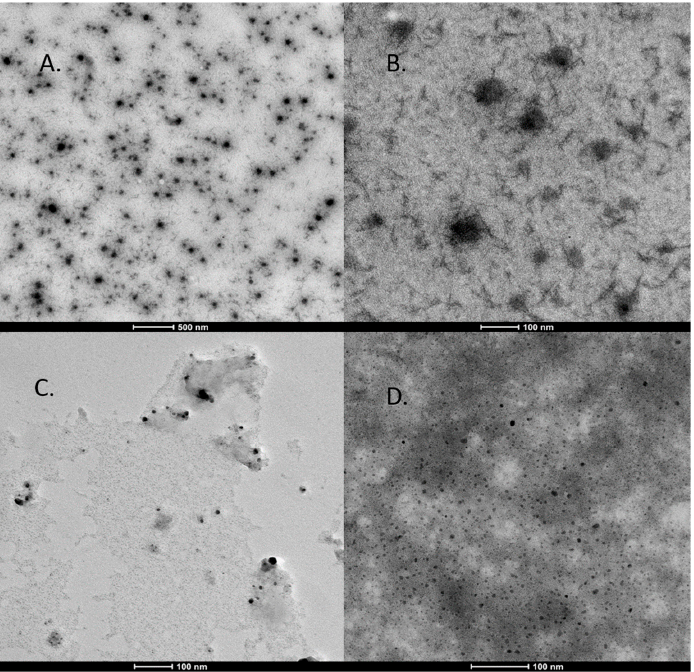
Figure 6. TEM analysis of bimetallic NPs. ( A , B ): Bimetallic nanoparticles with the internal core composed by Ag and the outer coating consisting of Pt. ( C ) Very tiny silver NPs ( D ) Platinum hollow NPs. Table 3. Inhibition zone (mm) of AgPtNPs against ATCC, MS and MDR bacterial strains. ( ± SD 3 replicates tested). Positive Control is Vancomycin for Gram-positive and Ampicillin for Gram-negative. Bacterial